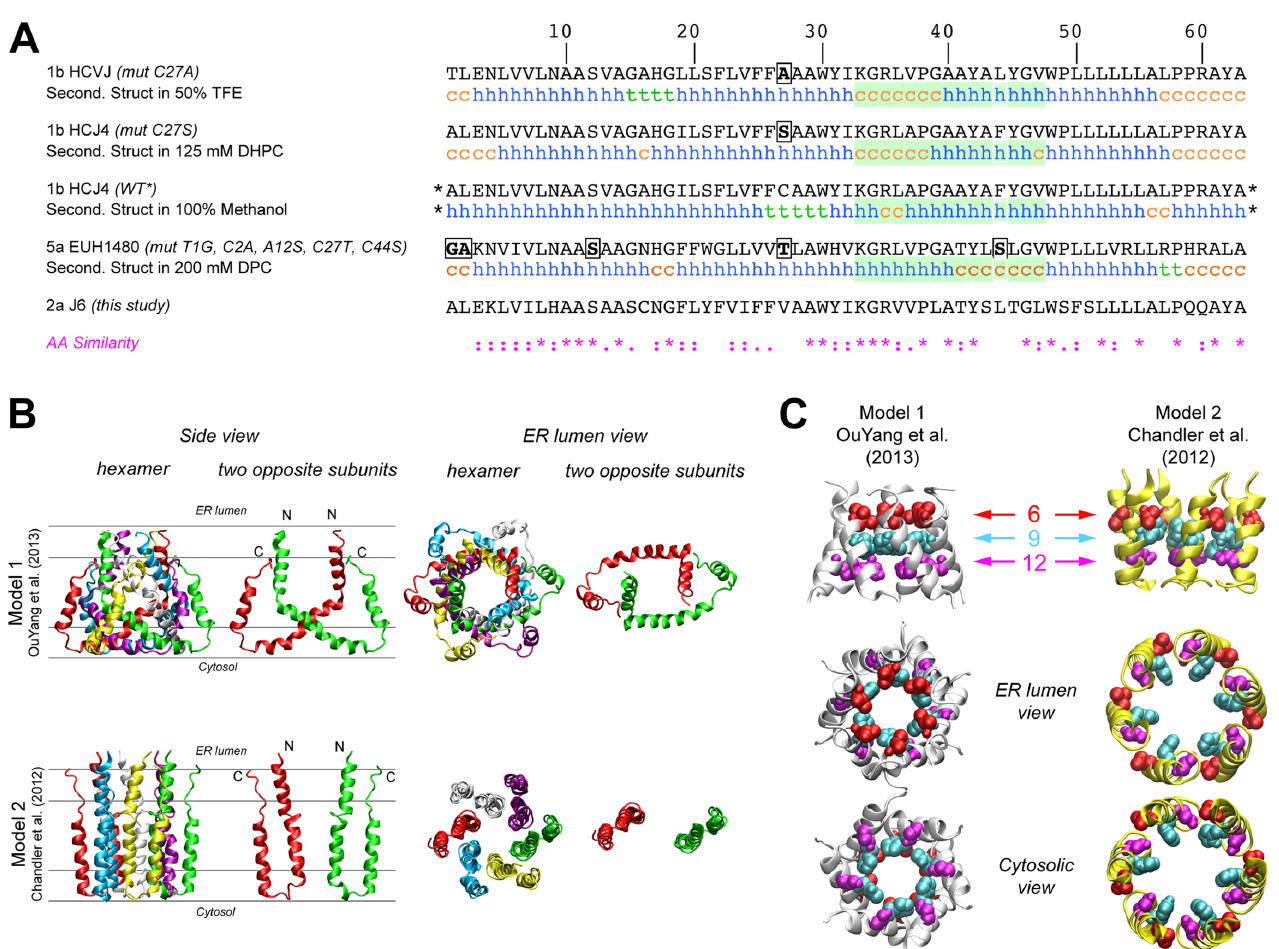
Fig 2. Comparison of p7 structure models identifies the N-terminal helical region as a potential key modulator of p7 function. A) Comparison of amino acid sequences and NMR secondary structural elements of p7 as determined by NMR in 50% TFE [41] (PDB entry, 2K8J), 125 mM DHPC [22] (PDB entry, 2MTS), 100% MeOH [42] (PDB entry, 3ZD0) and 200 mM DPC [47] (PDB entry, 2M6X). The stars ( * ) indicate that additional amino acids (N-terminal FLAG tag and C-terminal polylinker) were fused to this construct. The green box highlights a region where secondary structural elements are quite divergent across models, especially between monomeric (first three sequences) and hexameric (bottom sequence) NMR-based models. h, helix; c, coil; t, turn. The sequence of the p7 (J6) used in this study is also shown for comparison. An amino acid similarity index is used where asterisk indicates invariant, colon , highly similar and dot , similar. B) Comparison of the NMR model in DPC [47] and NMR/MD model in POPC [44] showing the hexameric form and two opposing subunits in the hexamer. Lines shown in the left hand panels represent the membrane interfaces and hydrophobic core (between the middle two lines). The positions of both models relative to the membrane bilayer were deduced from MD simulations in a POPC bilayer as previously reported for model 1 [53] and model 2 [44]. N- and C-termini are noted by “ N ” and “ C ” , respectively. C) N-terminal helical packing in both models demonstrates similar packing and residues 9 and 12 in both models point towards the pore. Figures were generated from structure coordinates by using VMD (http://www.ks.uiuc.edu/ Research/vmd/ [54]) and rendered with POV-Ray (http://www.povray.org/).